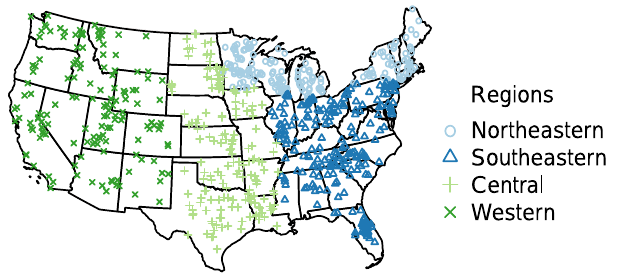
Figure 1. Survey locations colored by sampling year (1972 north- eastern: light blue; 1973 southeastern: blue; 1974 central: light green; 1975 western: